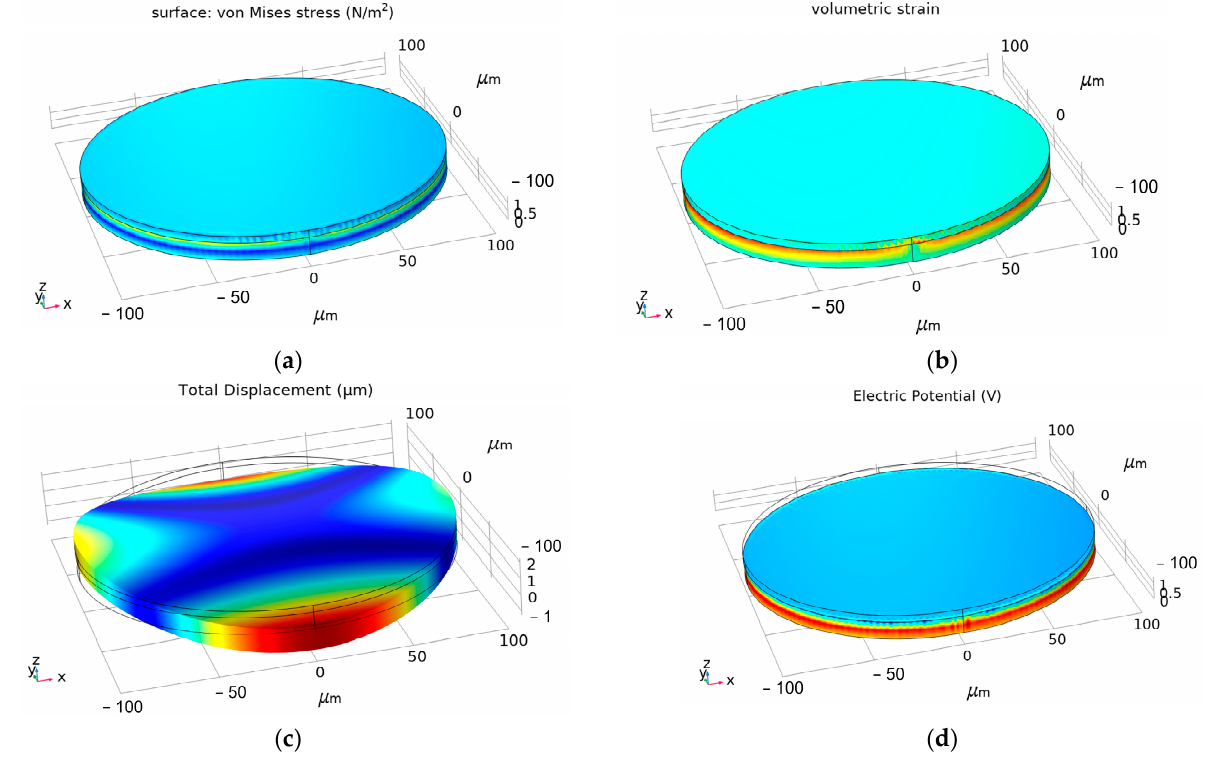
Figure 6. Distribution of the structure and electrical parameters of the ME antenna under a magnetic field. ( a ) Stress, ( b ) strain, ( c ) displacement and ( d ) electric potential.